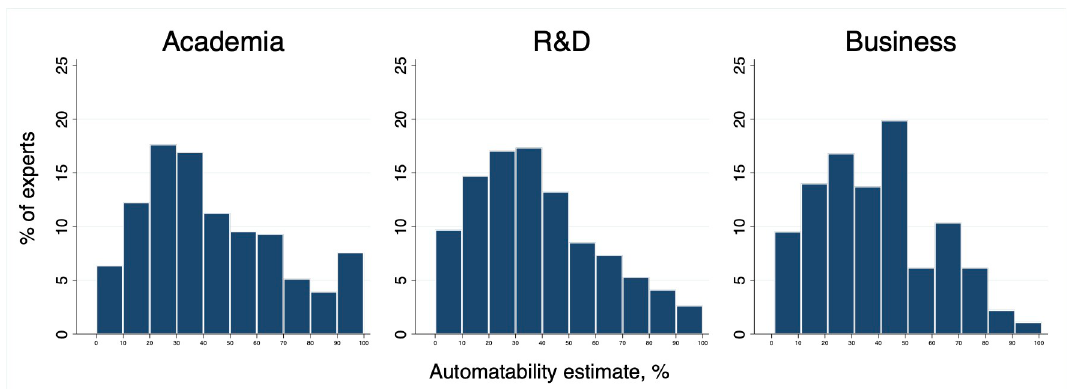
Fig 2. Distribution of estimates by experts’ professional background (10-year